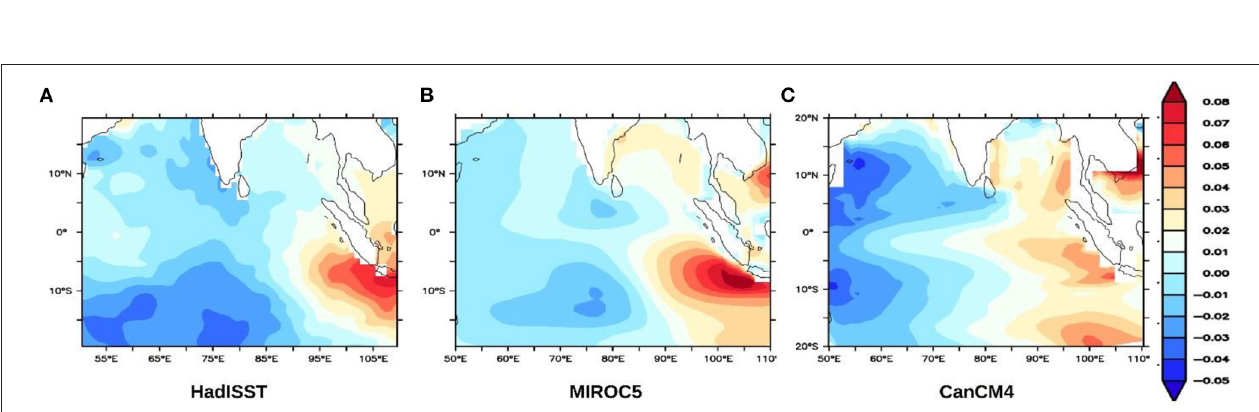
FIGURE 3 | The second mode from the EOF analysis of the tropical Indian Ocean SST, from (A) HadISST (1961–2011 period). (B,C) are the same as that of (A) but derived from MIROC5 and CanCM4 hindcasts for the same period (also see Supplementary Figure 2 ).